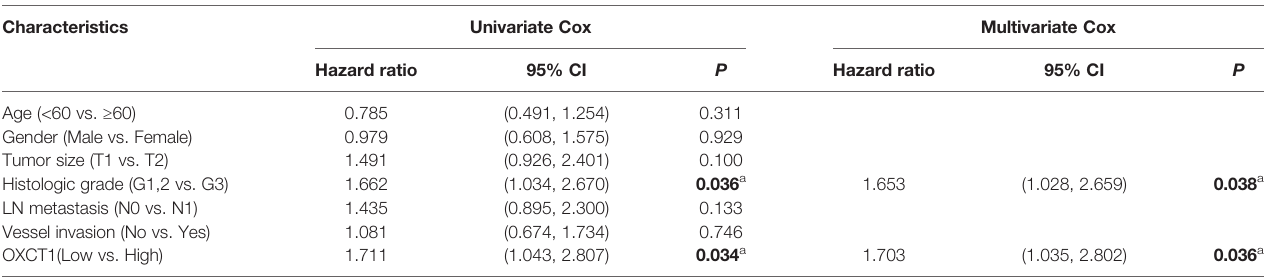
TABLE 2 | Univariate and multivariate analysis of clinicopathologic factors for RFS.